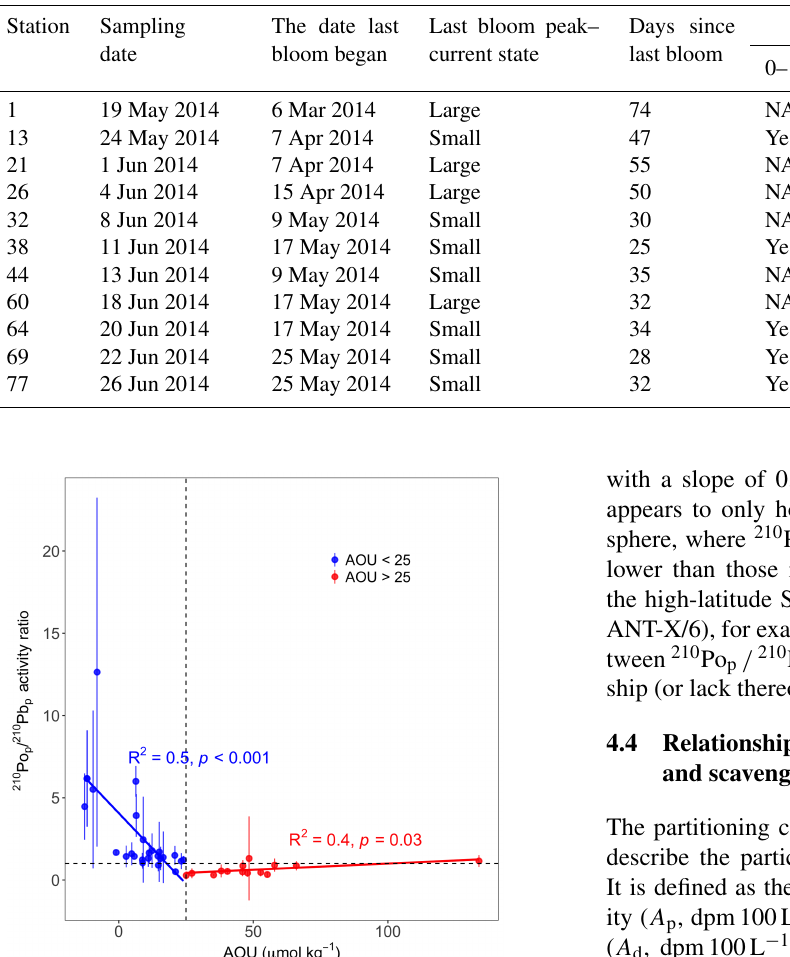
Table 1. Biological characteristics of the water column determined by chlorophyll- a concentration (8-day composite) from Fig. 6, including the date when the last bloom began, the difference in chlorophyll- a concentration between the sampling time and last bloom peak, and the days since the last bloom. Activity ratios of 210 Po p / 210 Pb p < 1 and their corresponding depths are also shown. NA indicates that all samples from the corresponding depth range had 210 Po p / 210 Pb p equal to or greater than 1 (no sample with 210 Po p / 210 Pb p < 1).